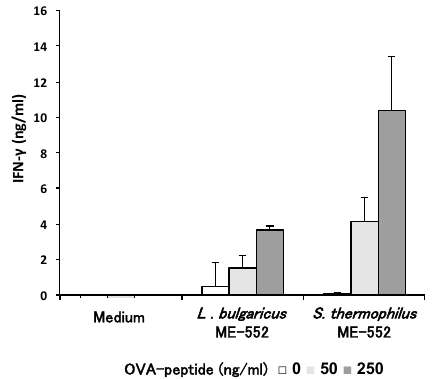
Figure 3. Effects of lactic acid bacteria on T cell response upon antigen-pulsed dendritic cells from Peyer’s patches. CD11c + cells that from the Peyer’s patch of wild-type mice were pulsed with OVA peptides (0, 50, 250 ng/ml) and co-cultured with naïve CD4 + T cells from spleen of OT- Ⅱ mice in the presence of heat-killed L. bulgaricus ME-552 or S. thermophilus ME-553 for 72 h. The ratio of cells in the co-culture was as follows; CD11c + cells:naïve T cells:ME552 or ME553 = 1:5:50. IFN- γ concentrations in the supernatant were determined using ELISA. Values are expressed as mean ± SD for three experiments. Different from the medium only, Student’s t- test was performed for p -values.